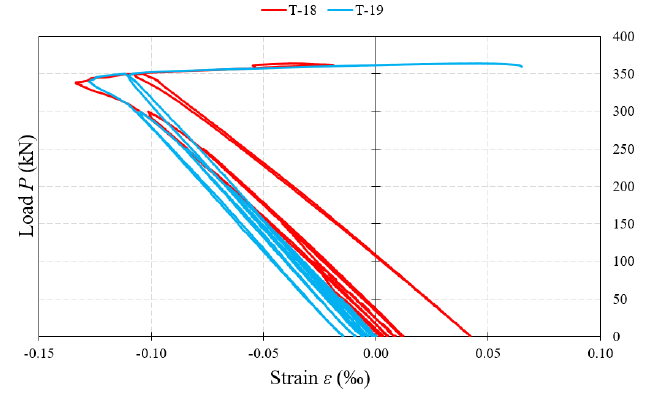
Figure 21. Load–strain relationship at the measurement points (T-18, T-19) located on the rib. Strain gauges located on the flanges of the tested beams clearly showed compression on the upper flanges and tension on the lower flanges (Figure 22). In beams with 5 mm-thick webs, at the time of failure, the strain exceeded the value of 2‰.